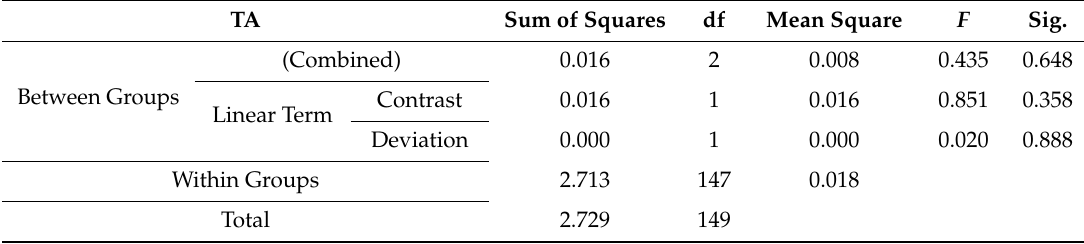
Table 3. ANOVA analysis for property of TA.